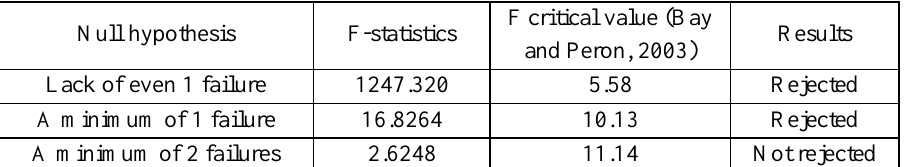
Table 14: Structural failure points in the liquidity time